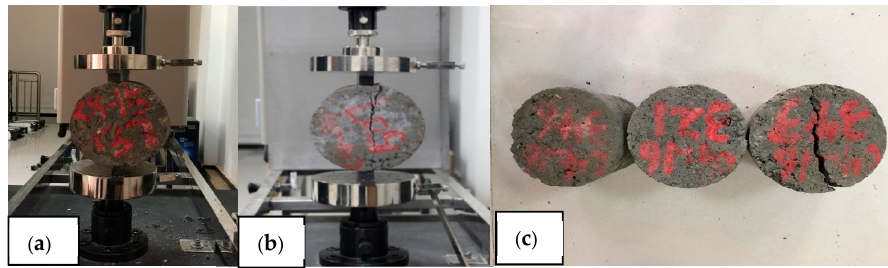
Figure 2. Indirect tensile strength test: ( a ). installation; ( b ). continuous loading; ( c ). damage.